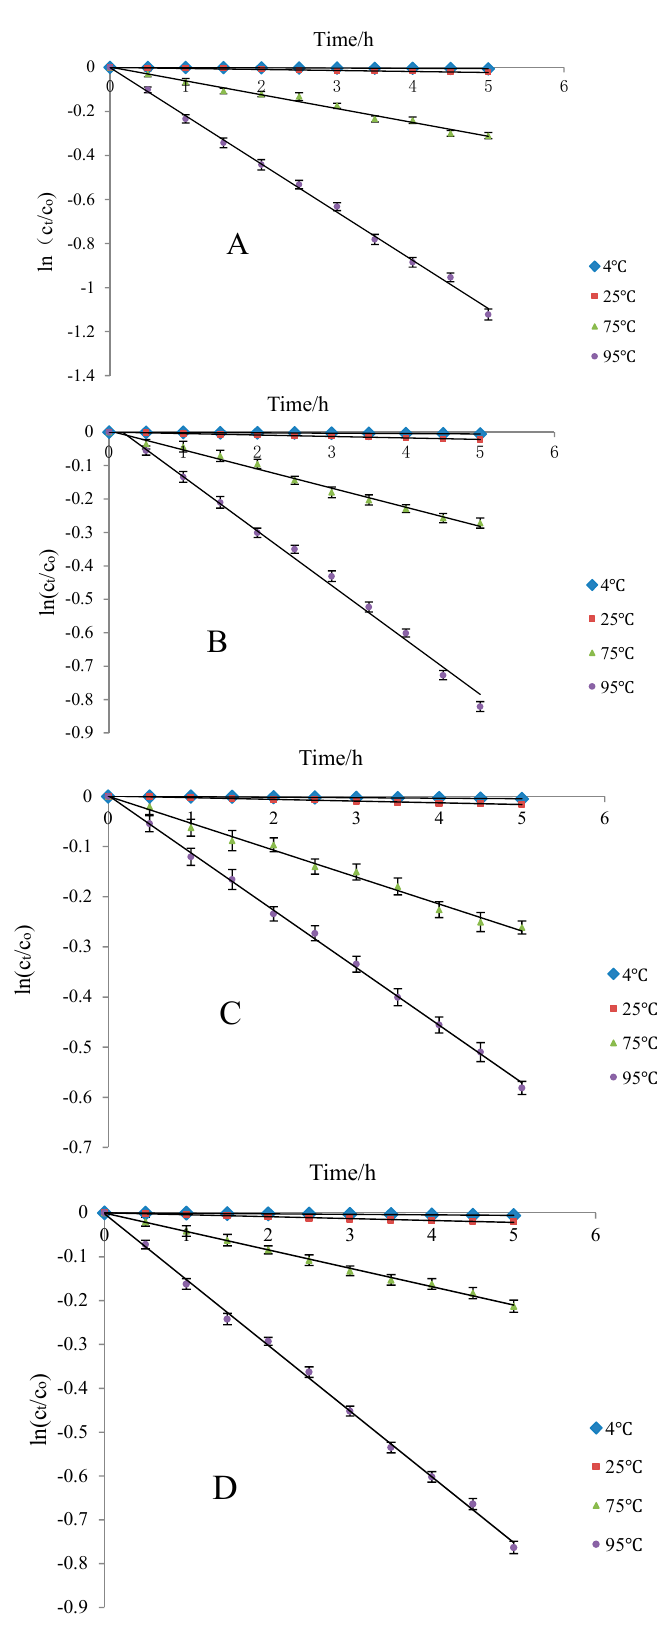
Figure 8. Thermal degradation of Cy-3-glu solution at different heating temperatures in different ethanol concentrations ( n = 3). Note: deionized water ( A ); 10% ethanol ( B ); 20% ethanol ( C ); and 50% ethanol ( D ).